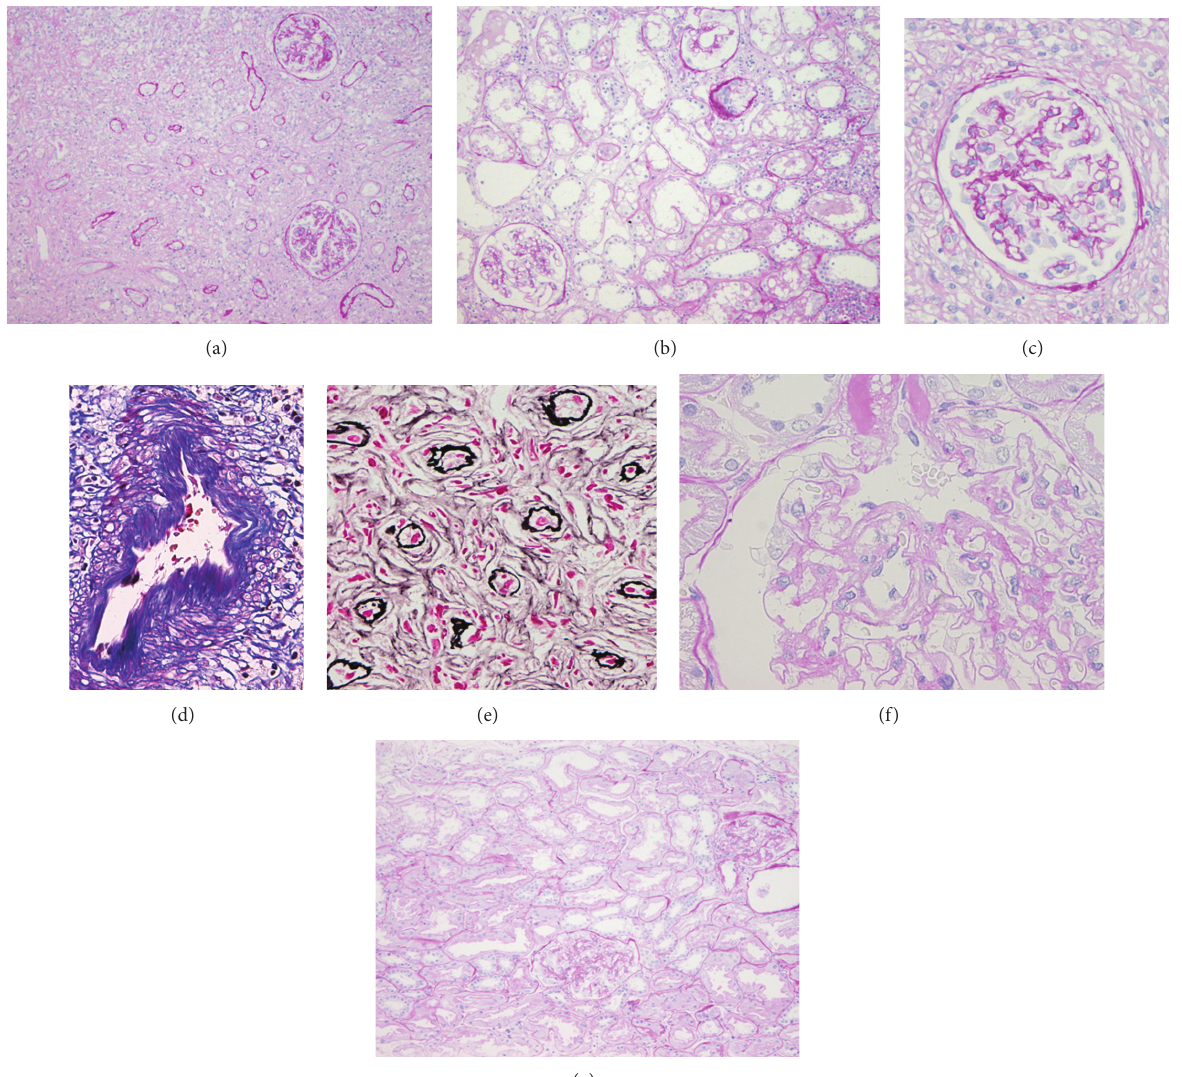
Figure 2: The first renal biopsy showed almost normal glomeruli, massively infiltrating cells, severe tubular atrophy, and abundant interstitial fibrosis ((a), PAS, ×100 ). Even in the almost normal area, mild cell infiltration and loss of tubular epithelia cells were observed ((b), PAS, ×100 ). Around the ischemic glomerulus ((c), PAS, ×200 ) and arteriole ((d), Masson, ×200 ), fibrotic fibers were observed. Most of these fibers appeared around tubules, and infiltrating cells formed a characteristic storiform pattern ((e), PAM, ×400 ). The second renal biopsy showed almost normal glomeruli with afferent arteriolar hyalinosis ((f), HE, ×400 ) and no tubulointerstitial damage ((g), PAS, ×400 ).